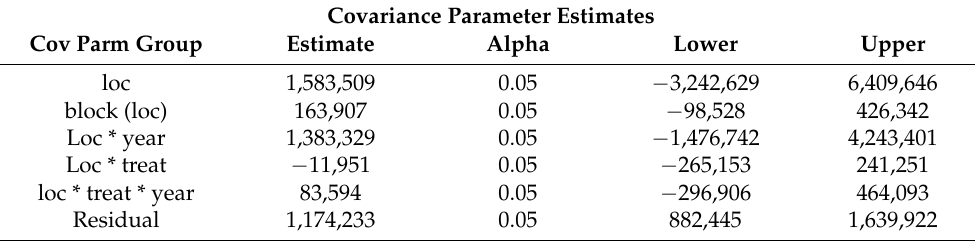
Table 5. Output 4: Partial output of the statistical analysis for location (loc) as random effect in the alfalfa study, no correlation